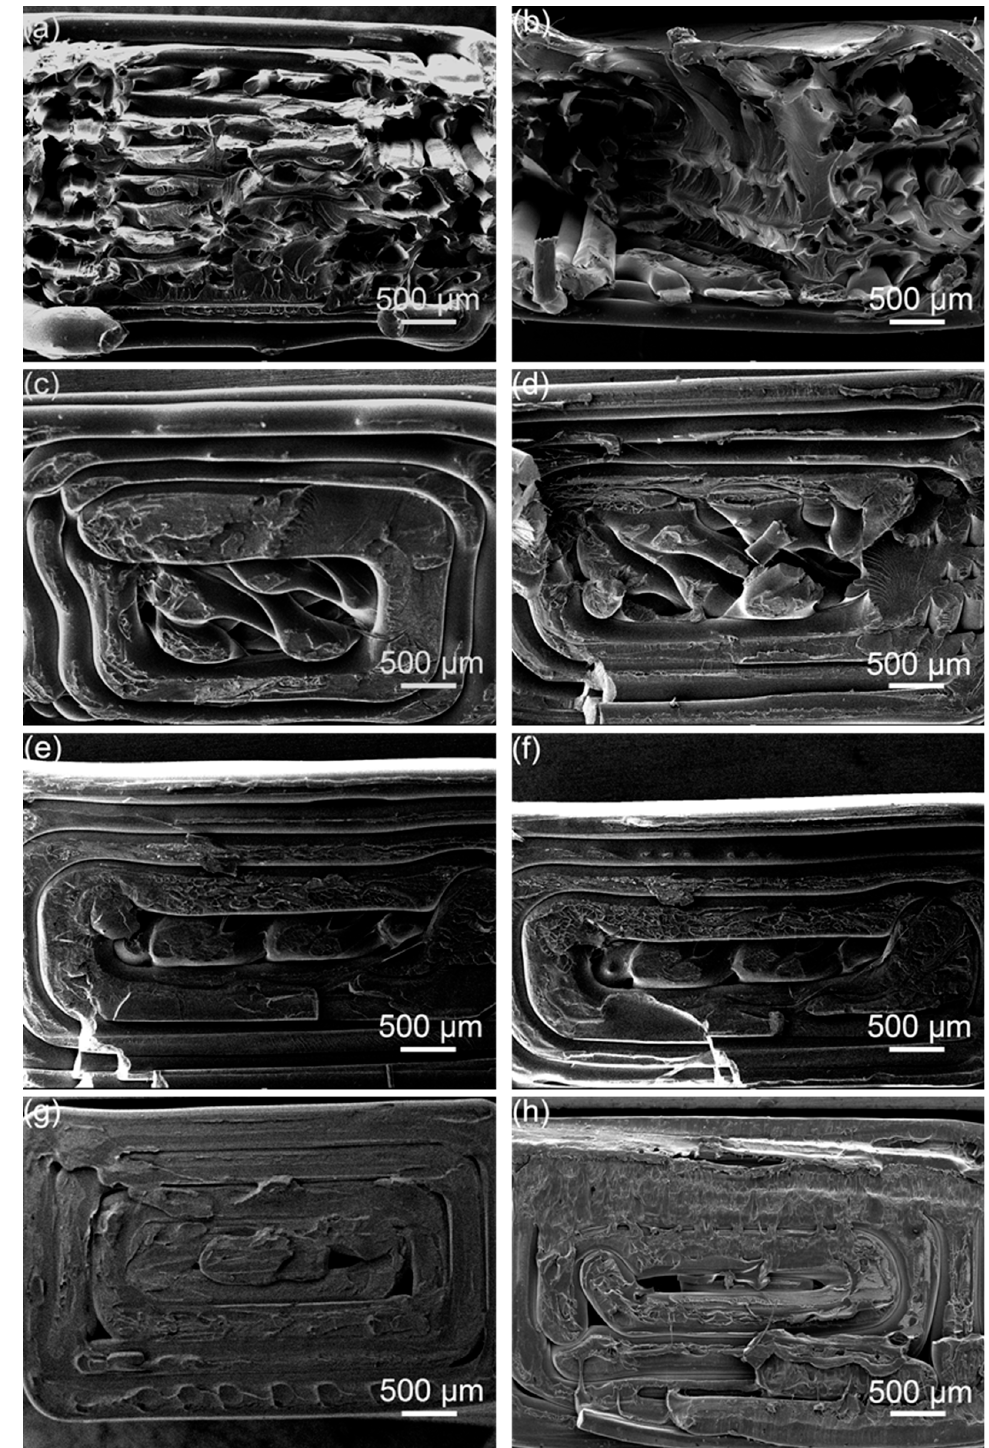
Figure 18. Electron micrograph of the original tensile cross ‐ section at the printing angles of ( a ) 15°, ( c ) 45°, ( e ) 60°, ( g ) 90°; the printing angles are ( b ) 15°, ( d ) 45°, ( f ) 60°, ( h ) 90° tensile cross ‐ sectional electron microscope images of ultrasonic reinforcements.